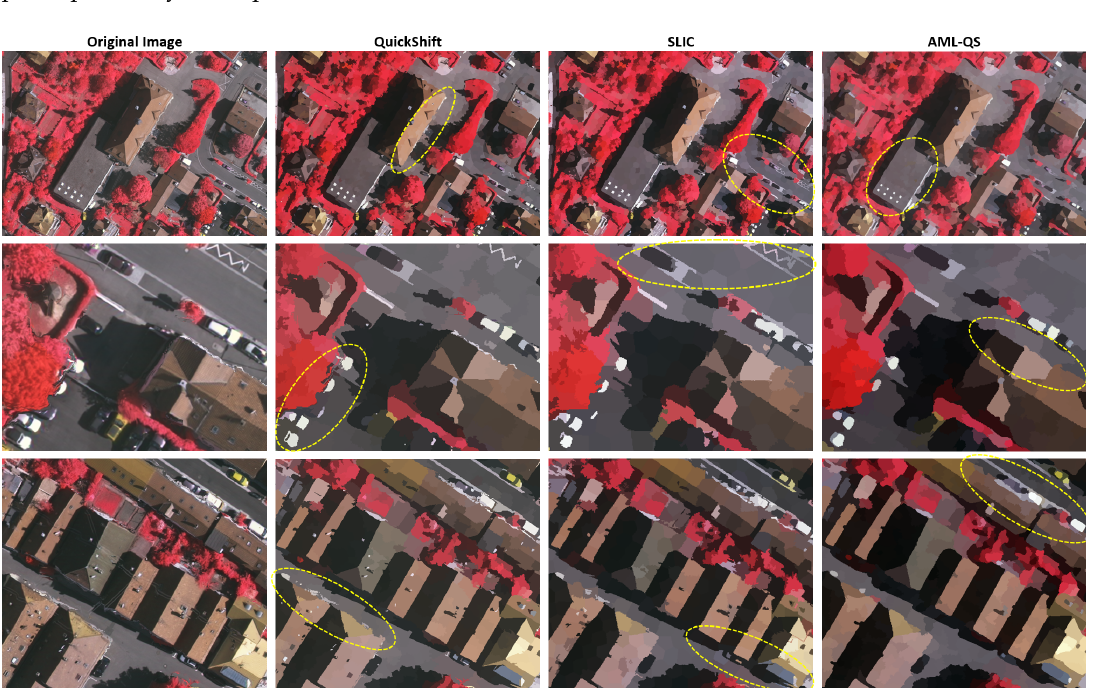
Figure 2. Comparing image objects derived from the Quickshift and SLIC algorithms with the proposed AML object-based approach (AML-QS). Image crops from the Vaihingen dataset are presented. Yellow dashed line: indicative areas where the proposed approach results into more semantically merged objects and more clear, accurate edges and